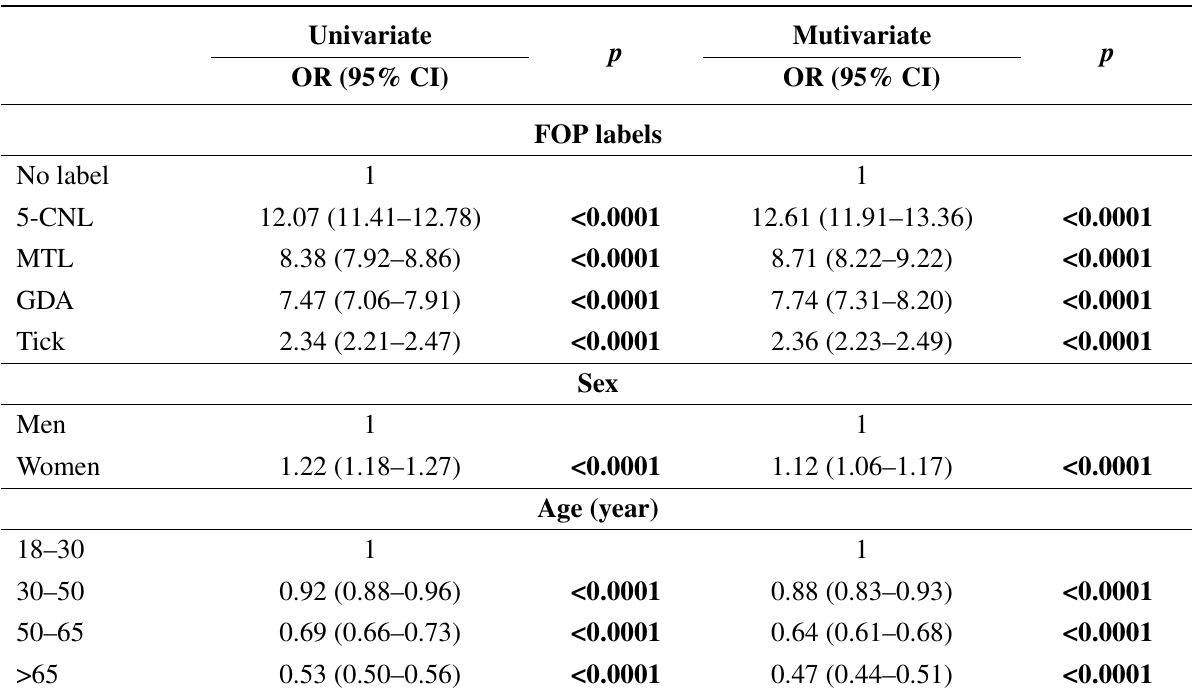
Univariate and multivariate analyses based on mixed models showing the association between Front-of-Package label formats and objective understanding ( N = 14,230) a